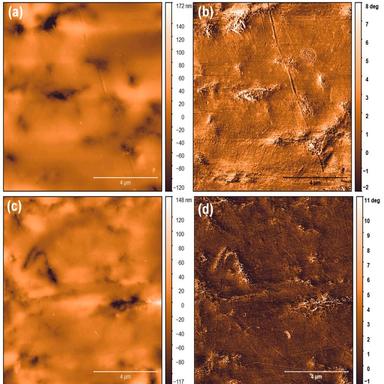
Top view AFM images at a 2.0 × 2.0 µm scanned area, (a) uncoated Ti6Al4V alloy, (b) uncoated Ti6Al4V alloy by using phase mode, (c) Ti6Al4V alloy containing Nb2O5 film, and (d) coated Ti6Al4V by using phase mode.